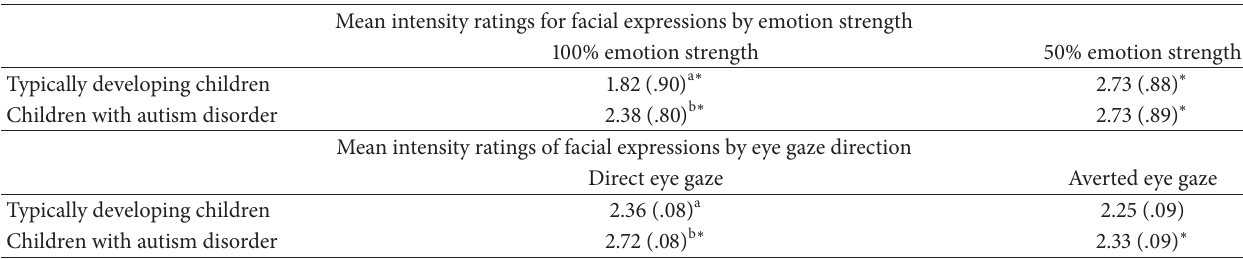
Table 3: Mean intensity ratings for facial expressions by emotion strength and eye gaze direction in children with AD and typically developing